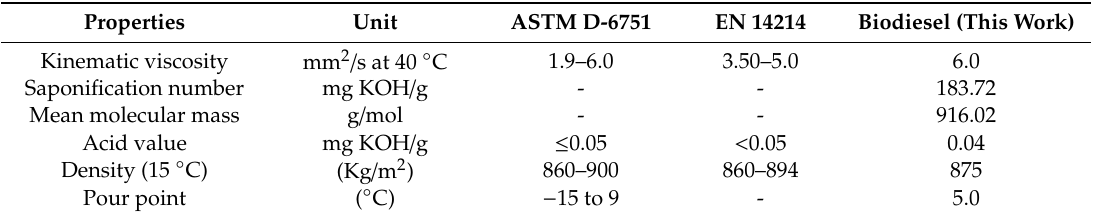
Table 4. Fuel properties of biodiesel produced from palm oil compared with the ASTM biodiesel standard. [43].